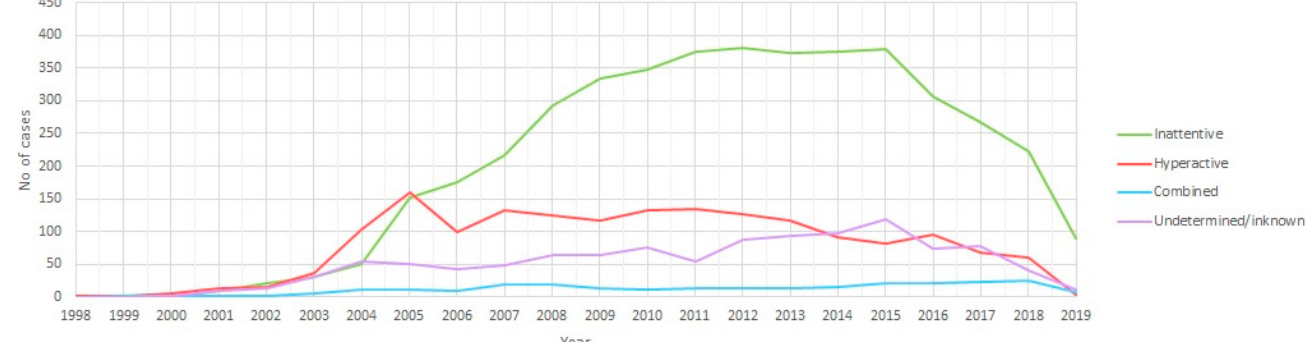
Figure 3. Incidence of Attention deficit hyperactivity disorder (ADHD) diagnosis by calendar year and ADHD profile (both males and females) (2019 data up to 20 November).